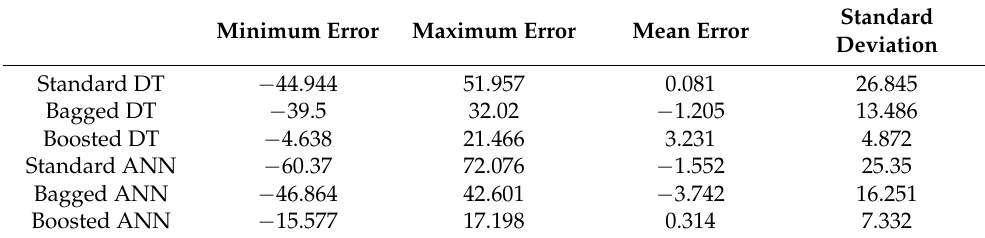
Table 5. Details of models’ error.